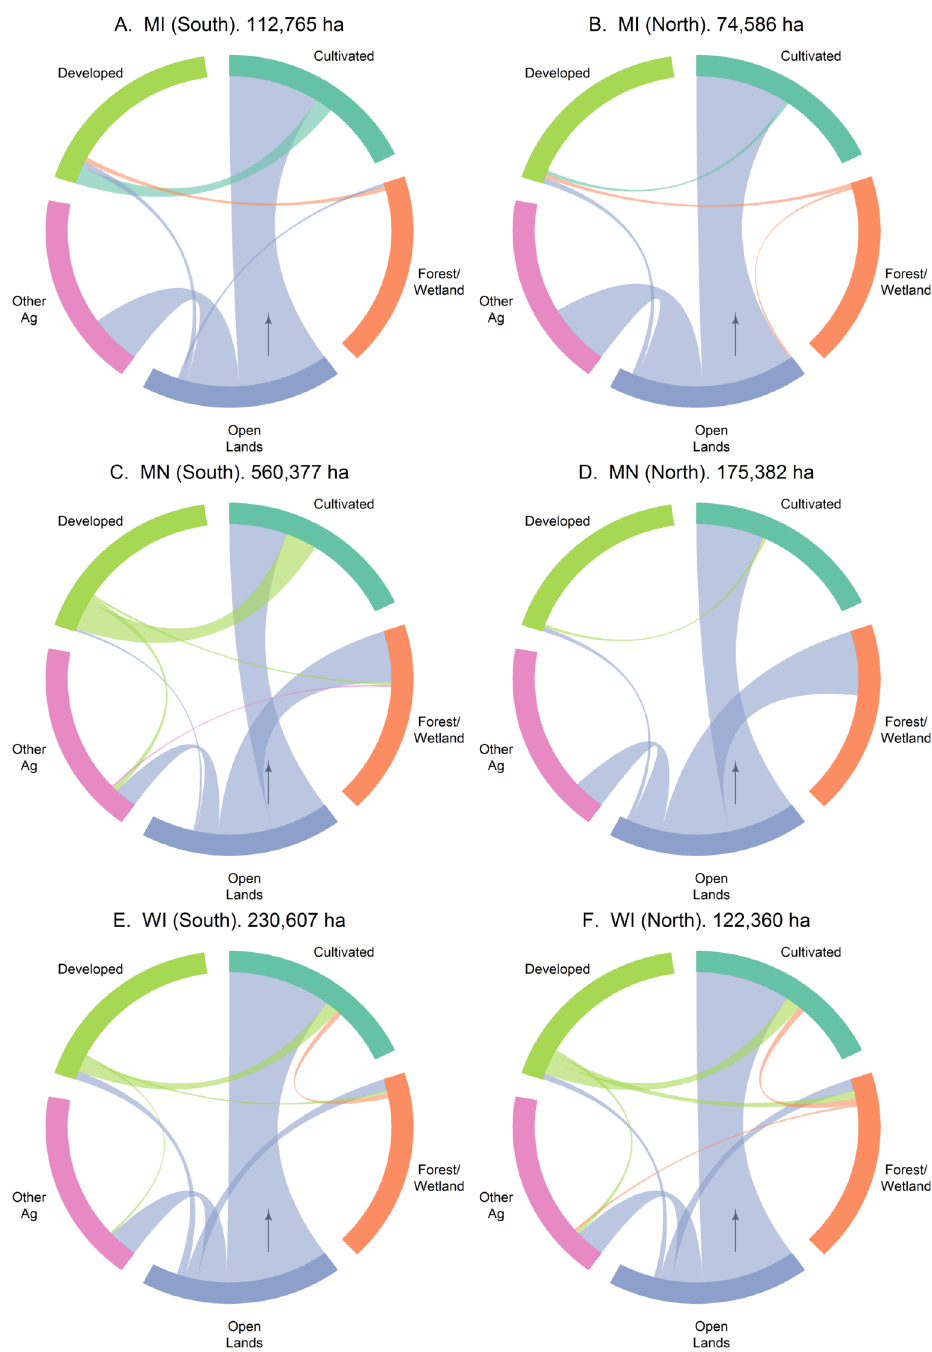
Fig 5. Transition diagrams depicting net changes in major land-cover groups between 2008 and 2013 in the northern and southern regions of each of the Lake States. The numerical estimates above each figure (A – F), represent the total area undergoing land-cover change in each region. The width of the arc represents the percentage of the total that is associated with a specific land-cover change transition e.g. cultivated to